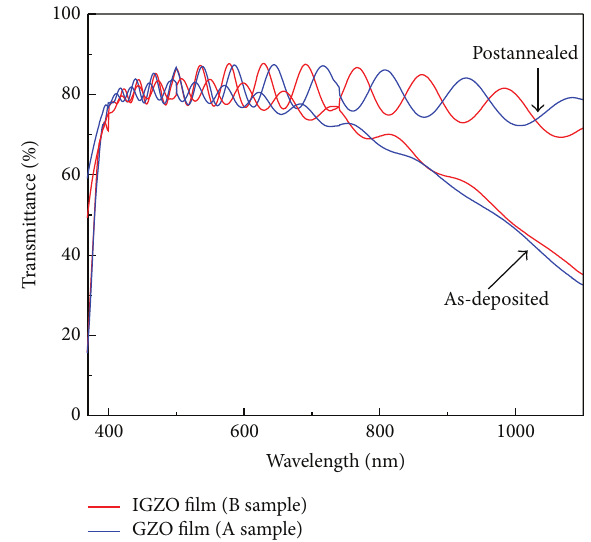
Figure 3: Transmittance of GZO (A sample) and IGZO (B sample) films in both cases of as-deposited and postannealed